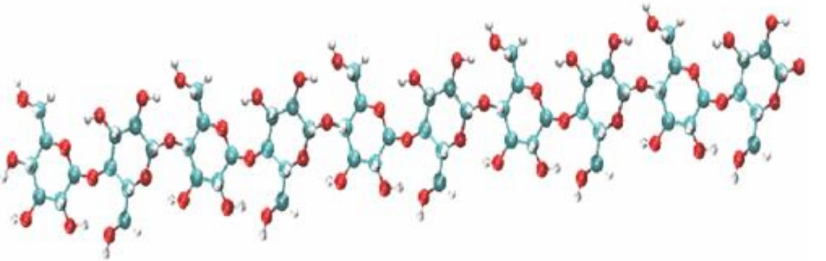
Figure 1. Cellulose molecular structure. Red: oxygen atoms; white: hydrogen atoms; blue: car- bon